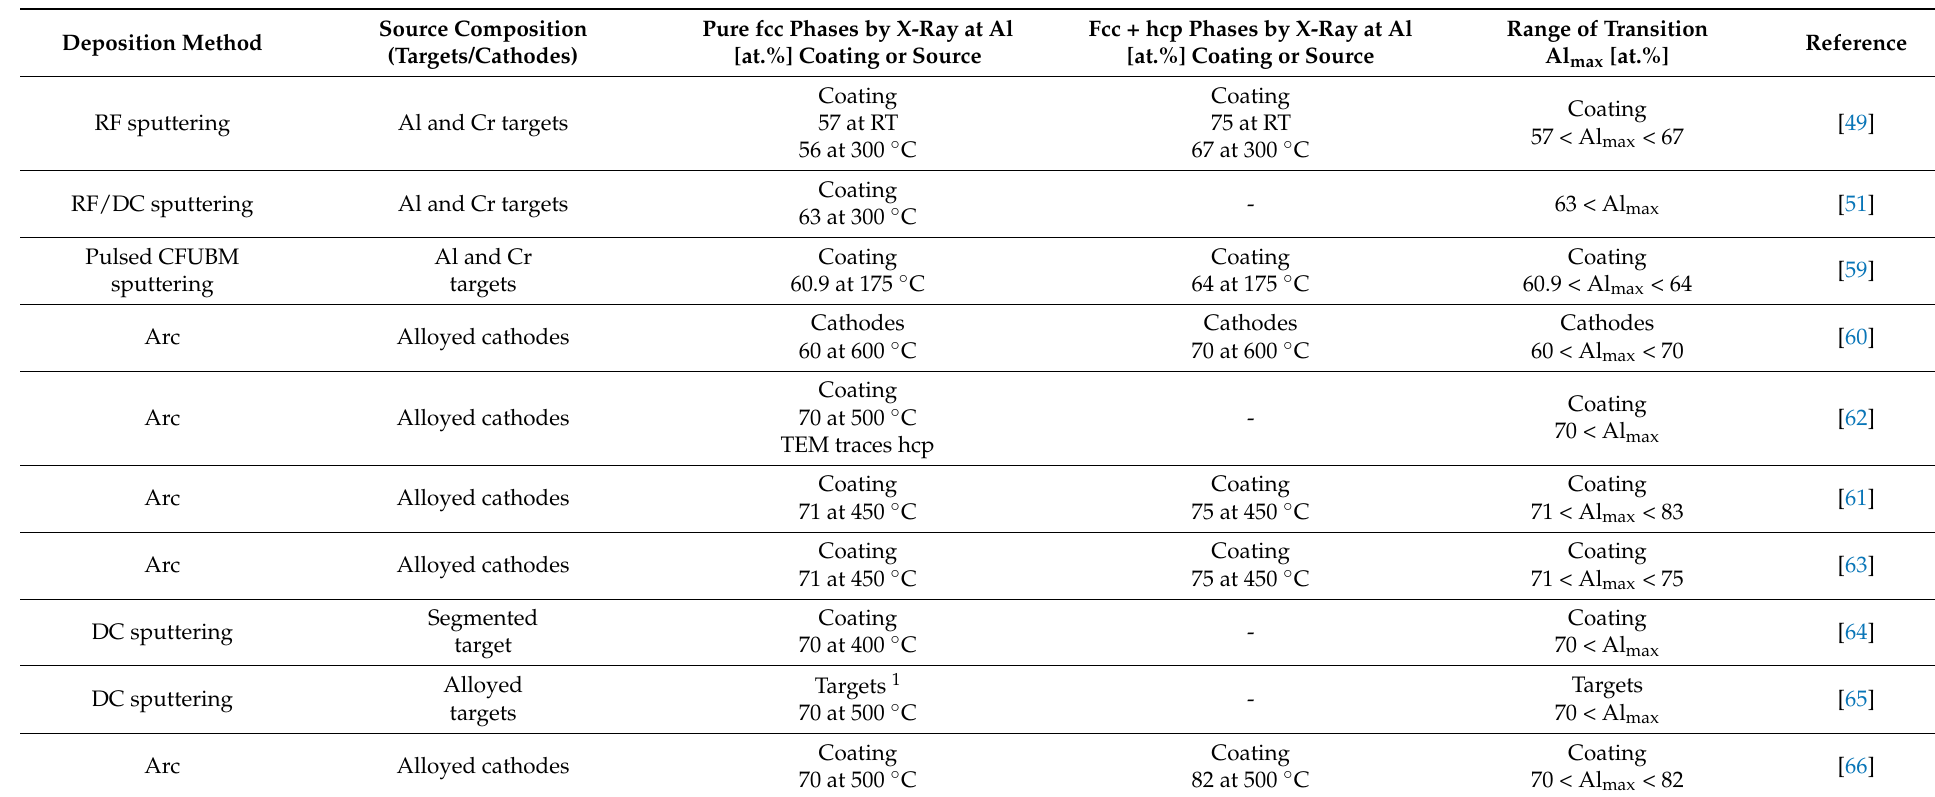
Table 1. Maximum Al content for pure fcc phase generation measured by X-ray diffraction for arc-deposited and sputtered